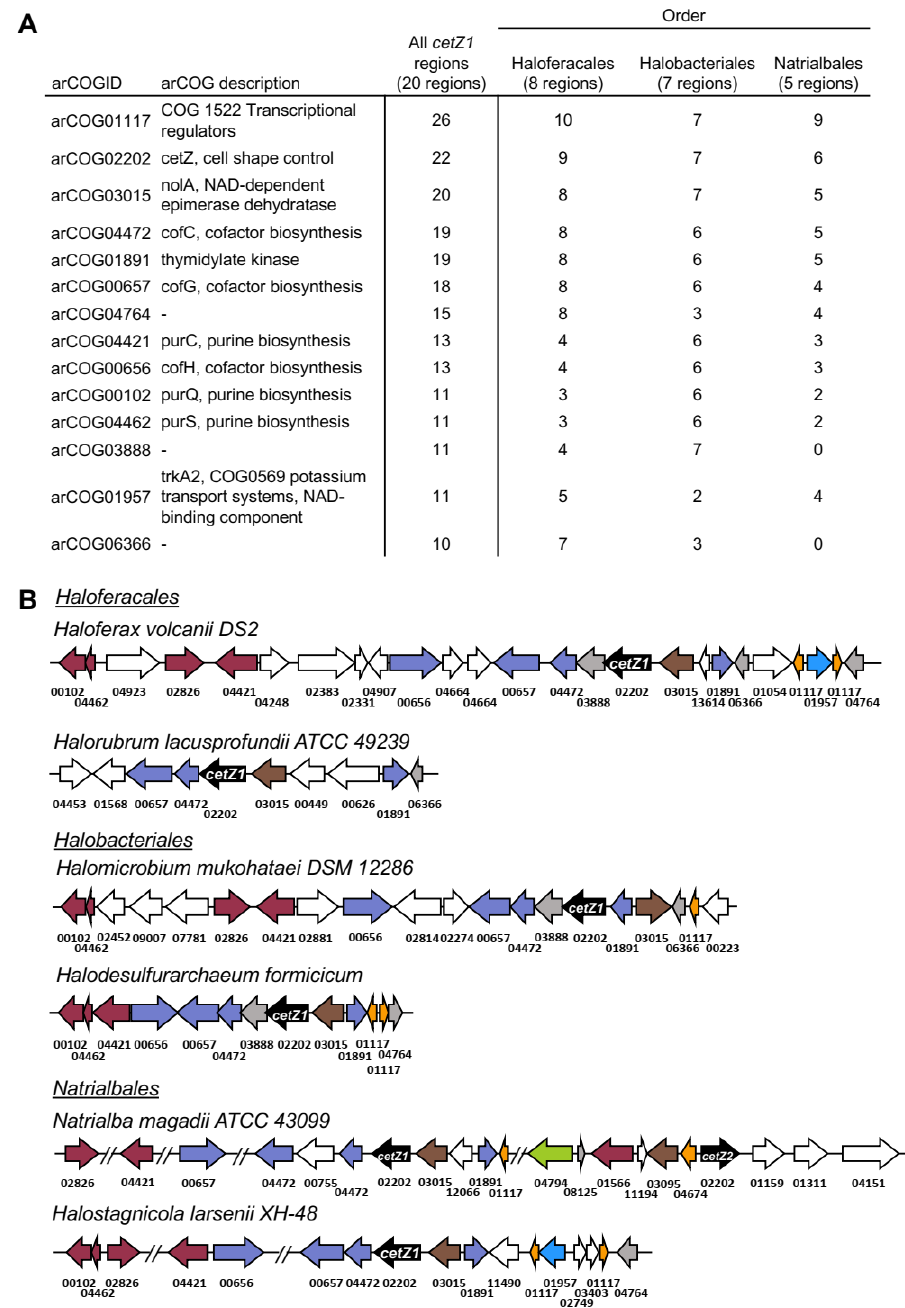
Figure 5. Conserved portions of cetZ1 genomic regions in selected Halobacteria. ( A ) The 20 kb regions on either side of the cetZ1 gene were analysed from 20 species of the orders Haloferacales (8), Halobacteriales (7), and Natrialbales (5). Table listing the most frequently observed arCOGs and their occurrence in 20 cetZ1 genomic regions from the orders Haloferacales, Halobacteriales, and Natrialbales. ( B ) Examples of cetZ1 genomic regions, showing their conserved residues only. The genes encoding cetZ1 are represented in black, and genes belonging to arCOGs present within majority (at least 10) of the cetZ1 genomic regions are coloured according to their COG category as detailed in Table S2; arCOGIDs are listed beneath each gene. arCOGs encoding uncharacterised proteins which are present in at least half of the cetZ1 genomic regions are represented in grey, and arCOGs not present in the majority of cetZ1 genomic regions are represented in white. In Natrialba magadii , ATCC 43099 cetZ2 was within the 40 kb cetZ1 genomic region, as well as some arCOGs often conserved within cetZ2 genomic